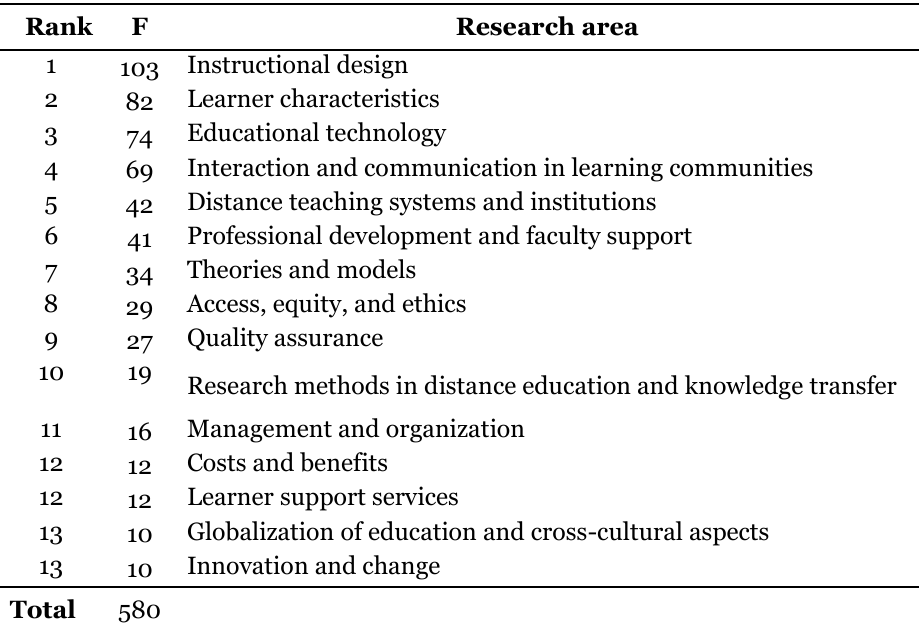
Distribution of Research Areas From 2000–2015 (N =